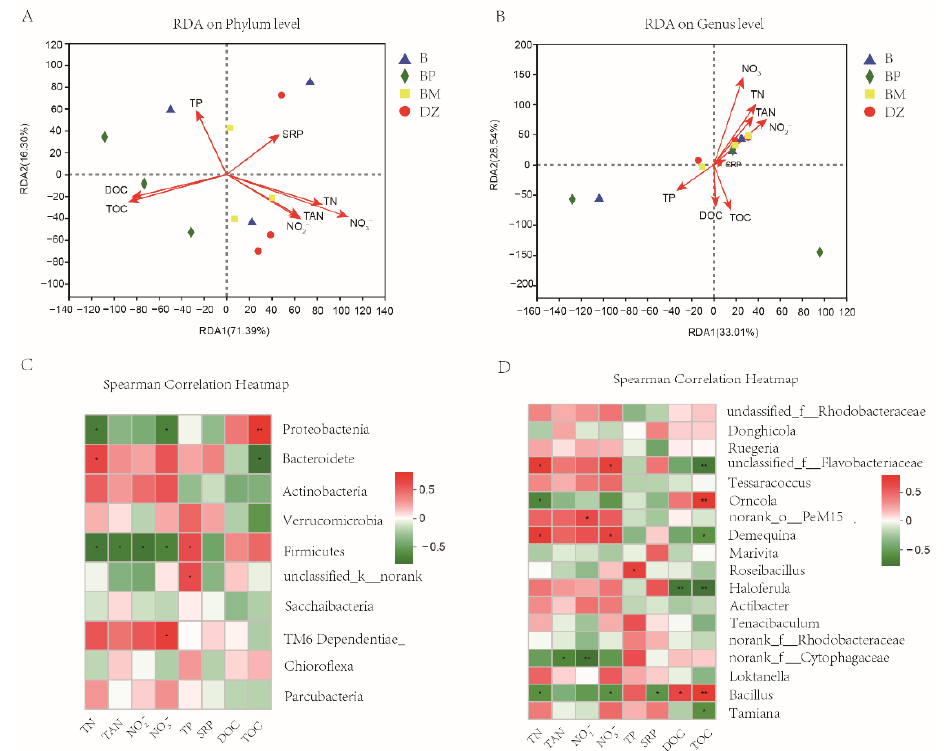
Figure 8. The Redundancy Analysis on phylum ( A ) and genus ( B ) level and the correlation heatmap analysis between bacterial taxa and water quality parameters on phylum ( C ) and genus ( D ). Note: group B, a single B. pumilus BP-171, was added; the group BP, B. pumilus BP-171, and PHBV were added; the group BM, B. pumilus BP-171, and molasses were added; the group DZ, the control without any probiotics and carbon sources addition.